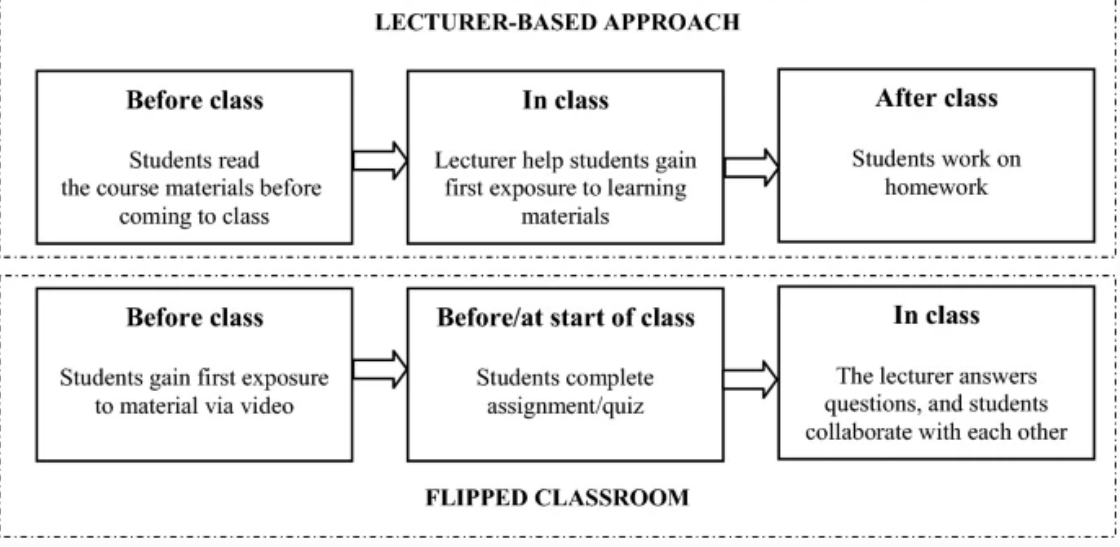
has four pillars (see Figure 2 below), namely: a flexible environment; learning